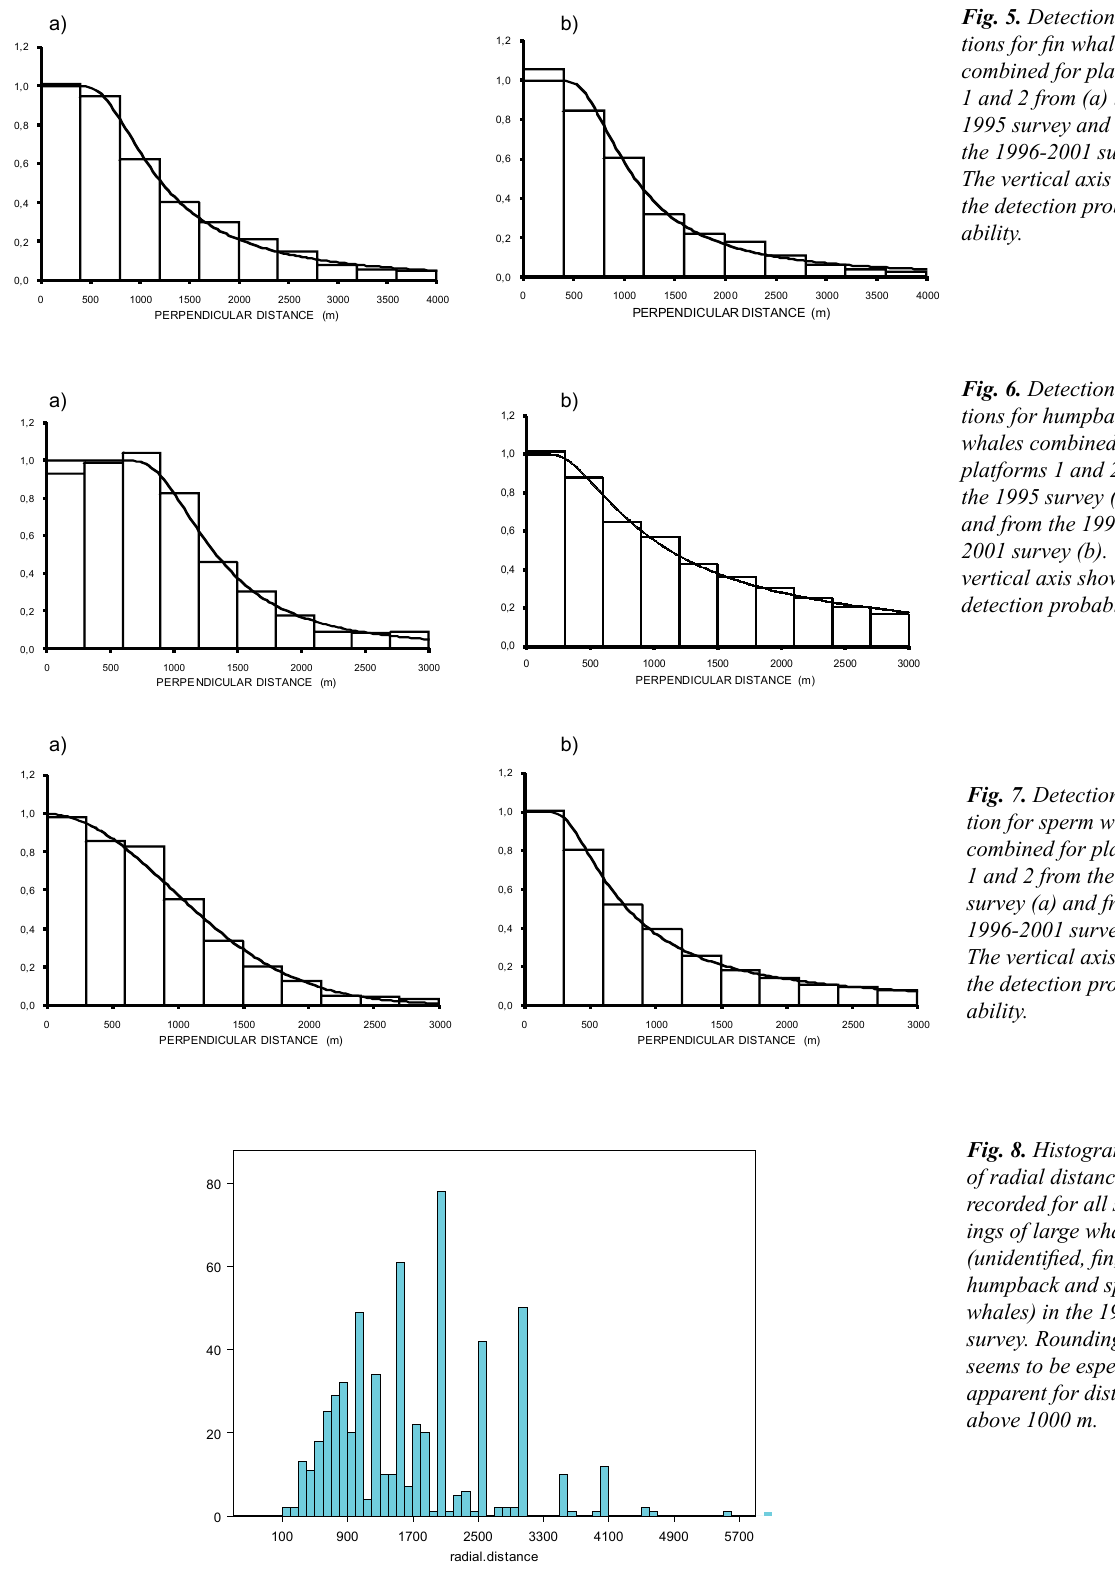
Fig. 8. Histogram of radial distances recorded for all sight- ings of large whales (unidentified, fin, humpback and sperm whales) in the 1995 survey. Rounding seems to be especially apparent for distances above 1000